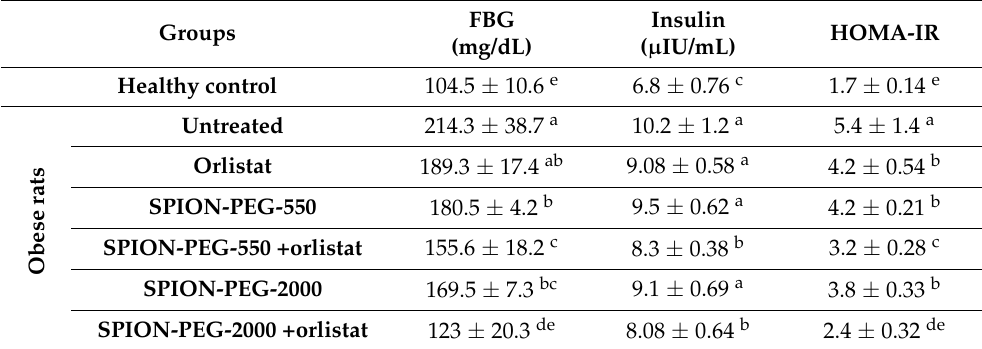
Table 3. Statistical analysis of glucose homeostasis parameters in the different studied